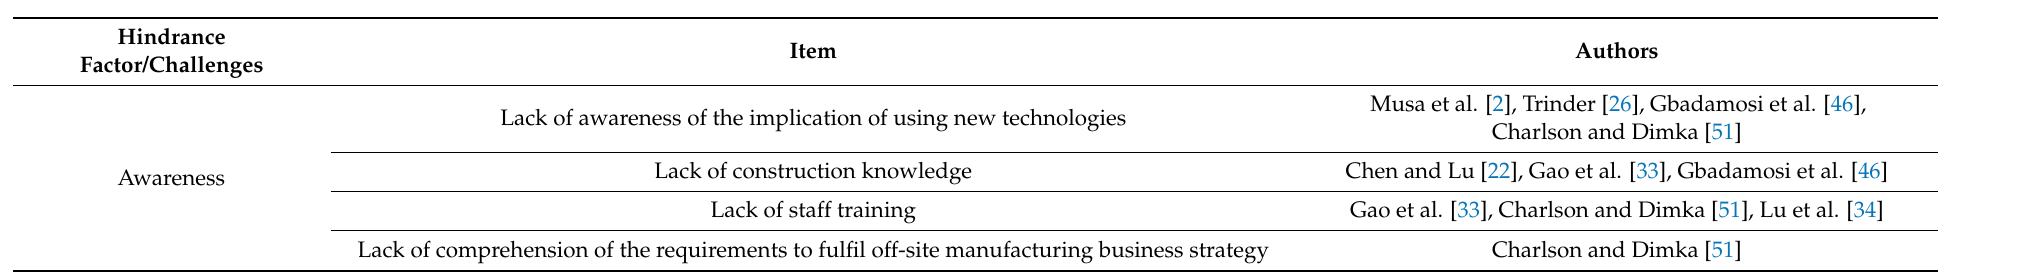
Table 3. Hindrance factors for DfMA/prefabrication